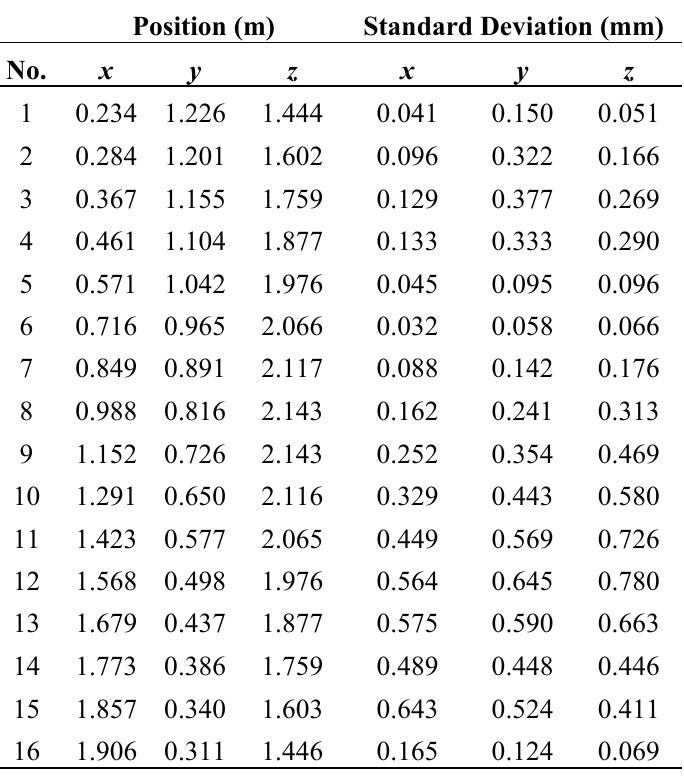
Table 3. Positions and standard deviations of the vertical